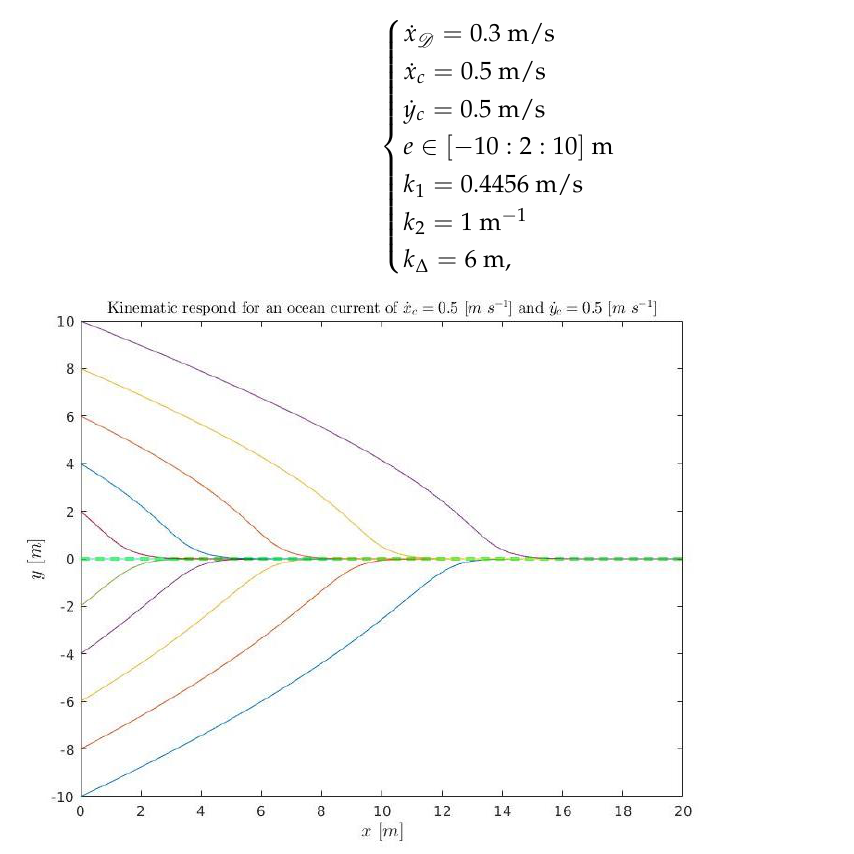
Figure 18. Kinematic simulation for the conditions (37) relative to position. The colored lines represent the different simulations and the green discontinuous line the acceptance tolerance.